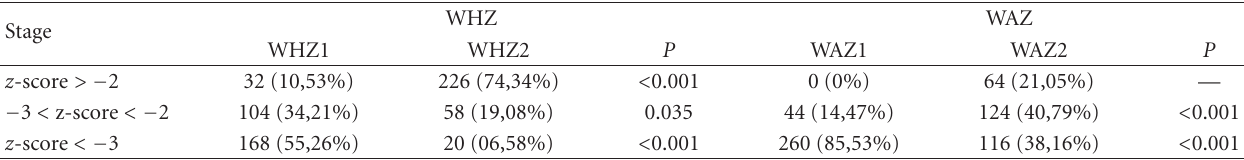
Table 7: Percentage of nutritional rehabilitation of children according to z